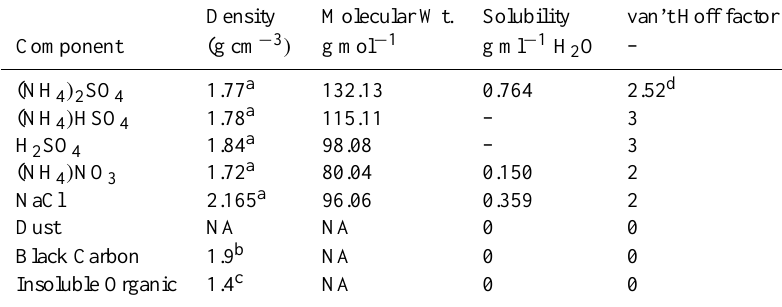
Table 2. Properties of components used to estimate CCN